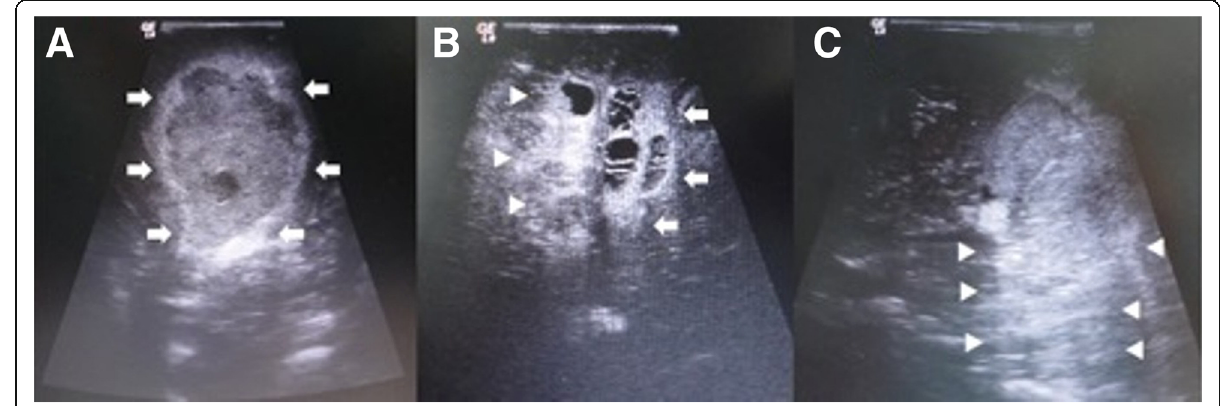
Fig. 2 Ultrasound ability to define tumor margins: a well-defined tumor margins, indicated by white arrows. b Moderately defined: the tumor margins can be clearly differentiated in some areas (white arrows) but not in other areas (white triangles). c Poorly differentiated: the tumor margins cannot be clearly differentiated (white triangles) all around the